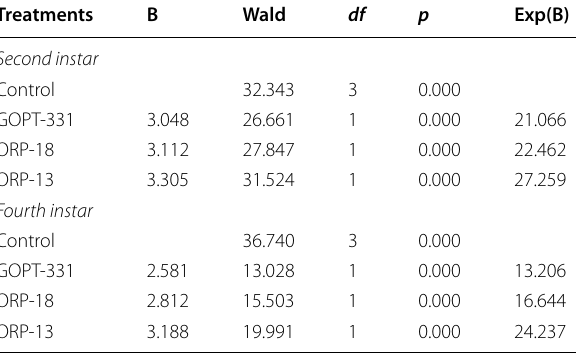
B Coefficient of regression, Wald significance of the regression coefficients, df degree of freedom, p significant, Exp ( B ) hazard proportion